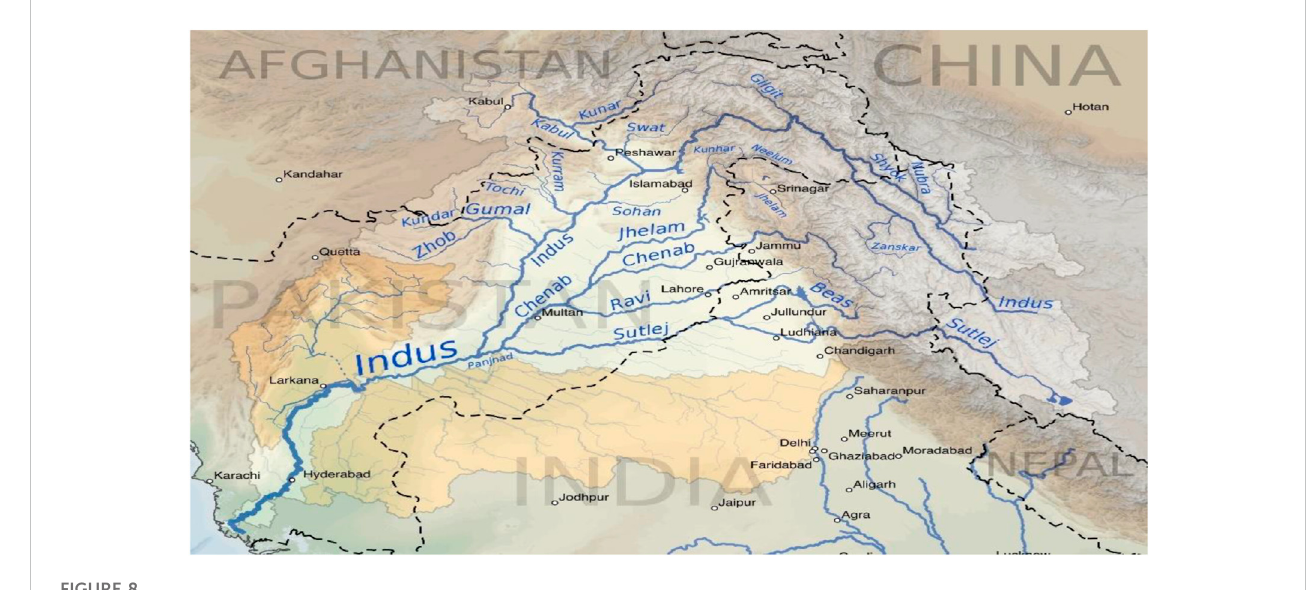
FIGURE 8 Indus rivers system in